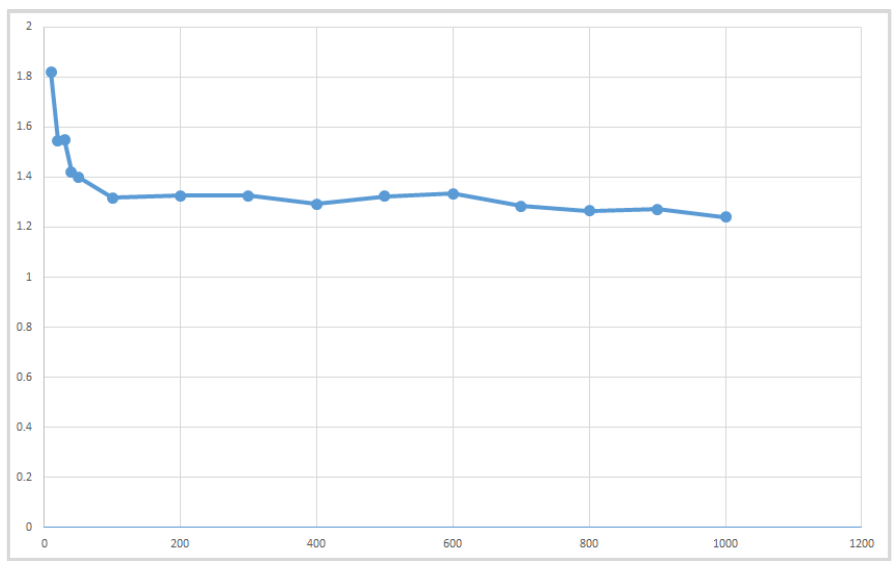
Figure 6. Approximation factor λ with maximum 1000